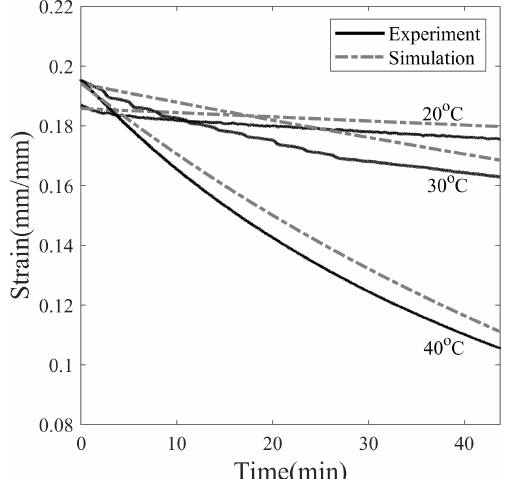
Figure 13. Stress-free isothermal recovery of SMP at temperatures 20, 30, and 40 °C after fixation of the temporary shape.